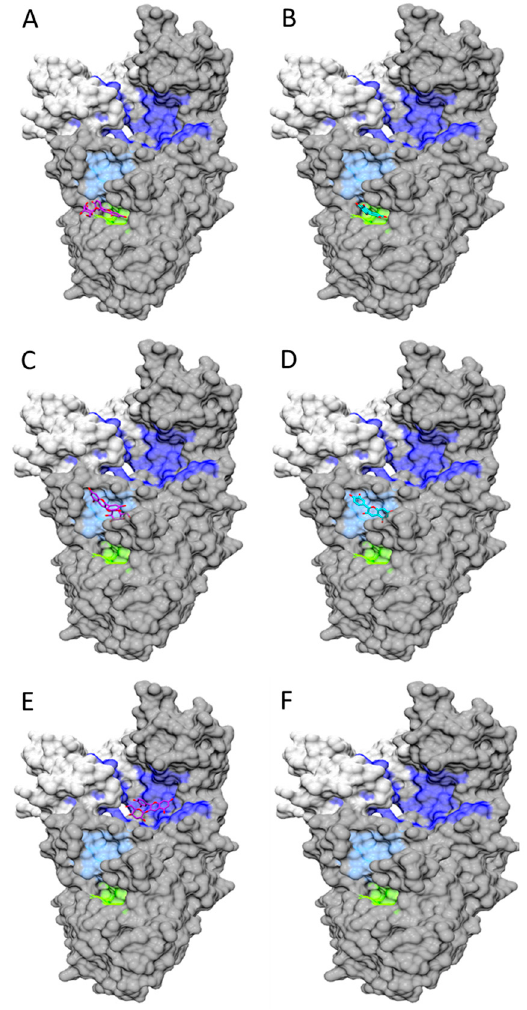
Figure 5. Docking simulation of Cy3G and Cy toward porcine lipase/colipase complex. Docking simulation details are described in Section 5.3. Cy3G ( left ) and Cy ( right ) within ( A , B, light green ) and near ( C , D; light blue ) the active site of lipase ( dark grey ) and at the binding region with colipase ( intense blue ; E , F ).